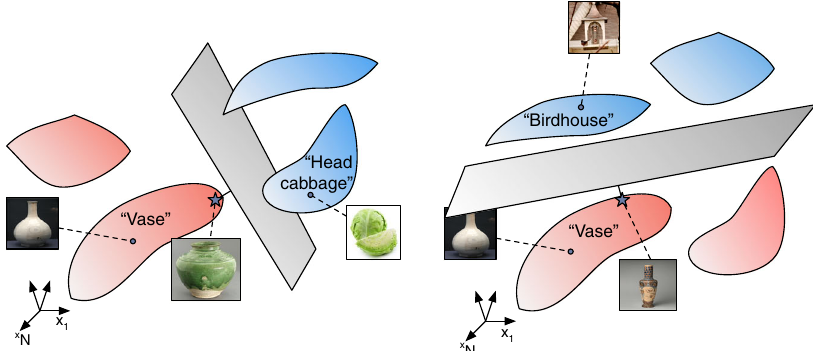
Fig. 2 Anchor points in an object manifold. Anchor points on manifolds de fi ne the optimal hyperplane separating a binary dichotomy of manifolds. This fi gure shows one realization of an anchor point on the ‘ vase ’ manifold (star) that separates it from the ‘ head cabbage ’ object manifold. Another realization illustrates a different anchor point on the ‘ vase ’ manifold when it is classi fi ed against the ‘ birdhouse ’ object manifold. The statistics of the distribution of these anchor points de fi ne the relevant geometrical manifold radius and manifold dimension of the ‘ vase ’ manifold that characterizes its linear classi fi cation properties